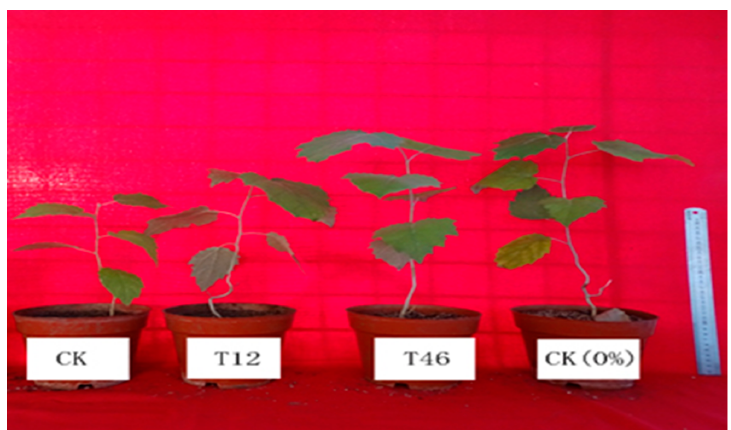
Figure 1. Growth after sodium chloride (NaCl) treatment. CK: non-transgenic poplar treated with 0.6% NaCl after 15 days, T-12: transgenic line T-12 treated with 0.6% NaCl after 15 days; T-46: transgenic line T-46 treated with 0.6% NaCl after 15 days, CK (0%): non-transgenic poplar treated with 0% NaCl after 15 days.